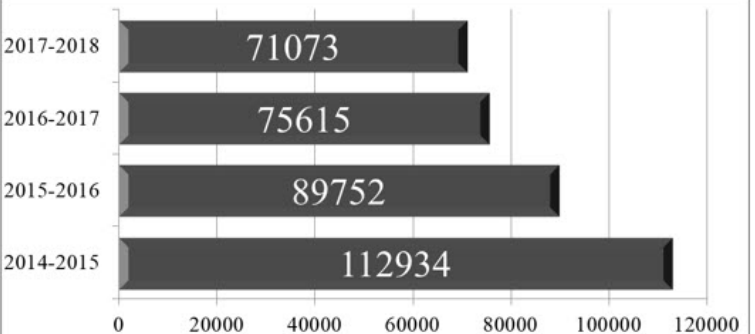
Figure 5. The number of foreign citizens studying in higher education organizations on a contract basis for 2014-2018, people